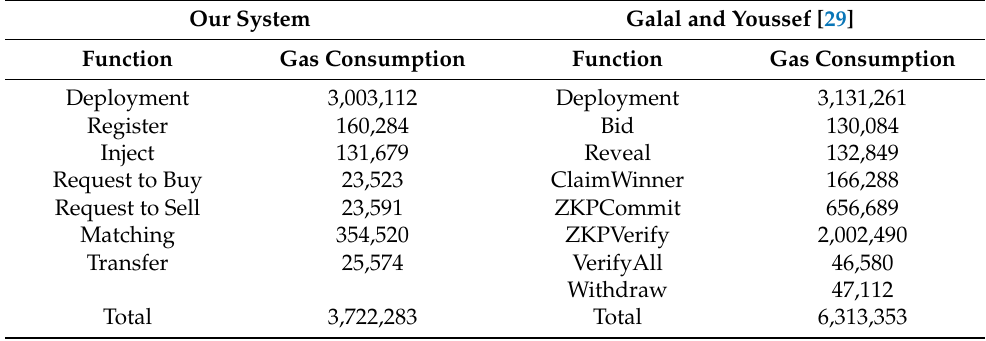
Table 10. Comparison of our system against Galal and Youssef [29] in terms of gas consumption.